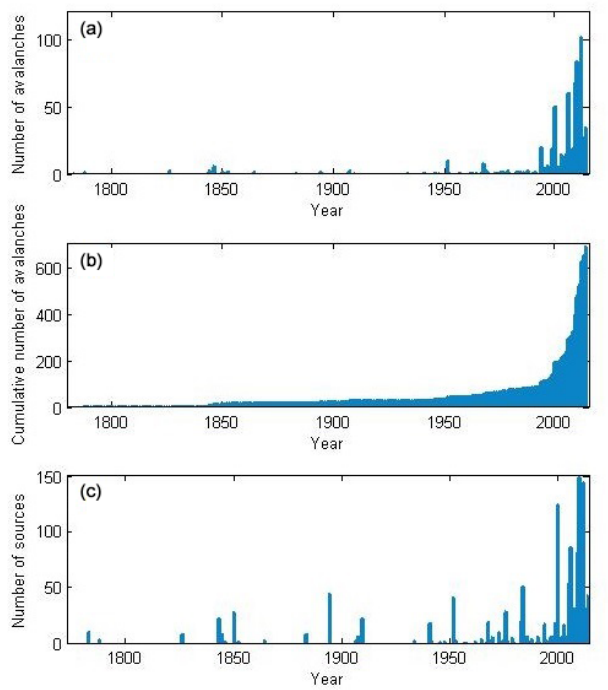
Figure 4. Number of avalanches (a, b) and number of distinct sources (c) as a function of time. In (a) (number of avalanches per year) and (b) (cumulative plot), only the 682 avalanches with known year (winter) are